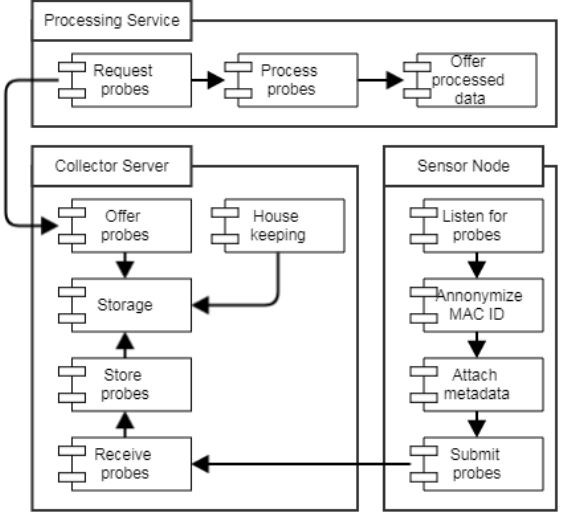
Figure 1. WLAN probe collection system architecture: the sensor node (lower right) is placed on the bus and it receives probes from WLAN devices. The collected probes are, after some processing, sent to the collector service (lower left), which stores them and makes them available to services for further processing. The processing service (top) retrieves the stored probes and processes them, in the case of this paper, for estimation of the bus